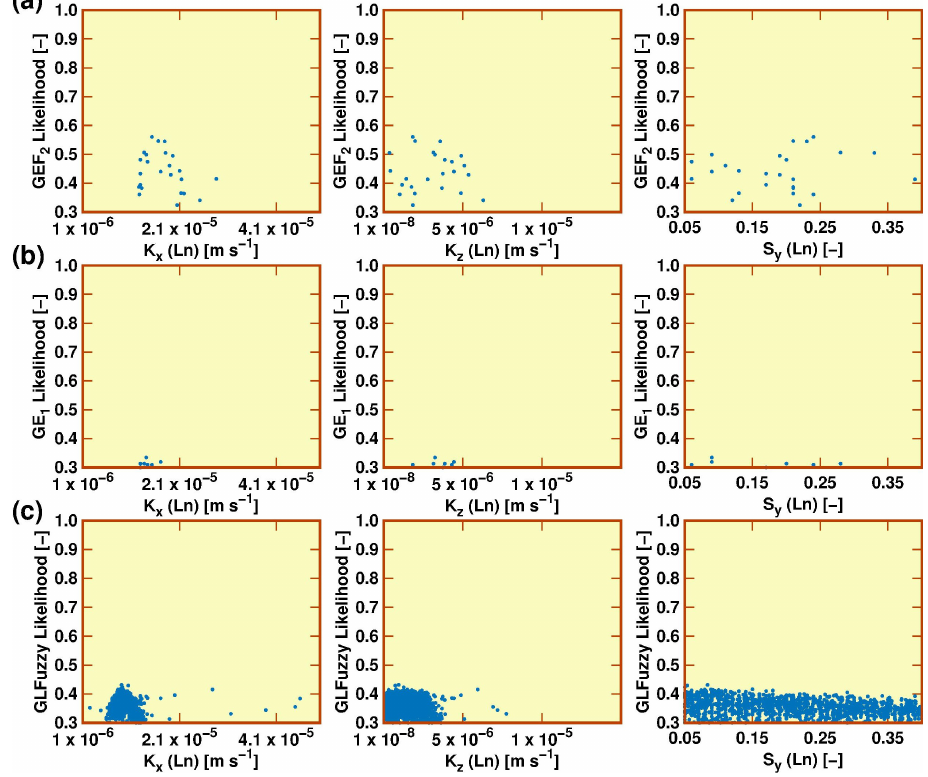
Figure 6. Scatter plots of behavioural parameter sets (likelihood target was 0.25), for three of the inspected parameters, in the validation period [1 September 1985–1 March 1986], after conditioning based on observed streamflow at the outlet of the catchment and at two internal locations (i.e., a multi-site (MS) validation test) and considering the H-Q data uncertainty: ( a ) using the EF 2 index; ( b ) using the E 1 index; and ( c ) using the linear fuzzy likelihood measure ( LFuzzy ). “G” denotes that the likelihood measure is “global” (MS